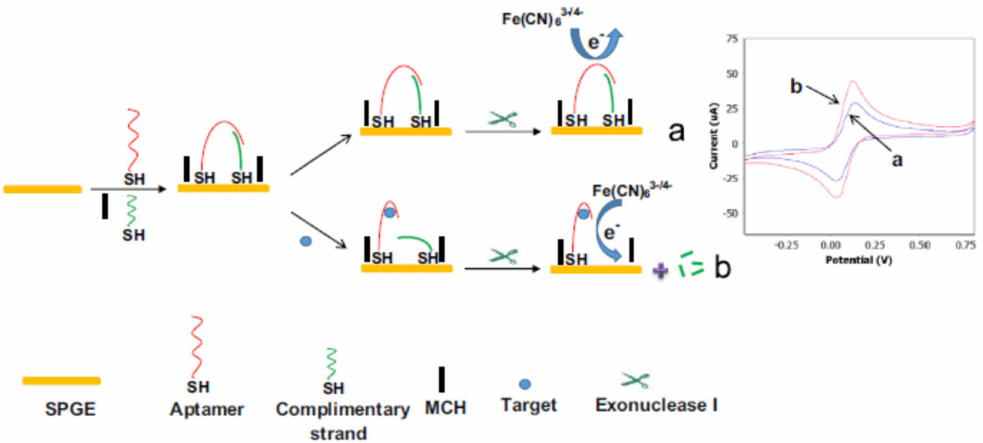
Figure 18. Schematic illustration of the signal amplification by Exonuclease I for the detection of streptomycin in milk. Reprinted from reference [80] with permission from